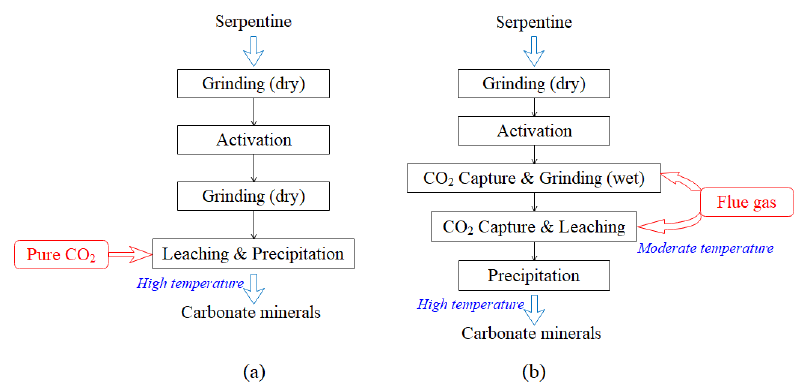
Figure 12. Mineralization process concept for (a). pure CO 2 , (b). flue gas (modified from